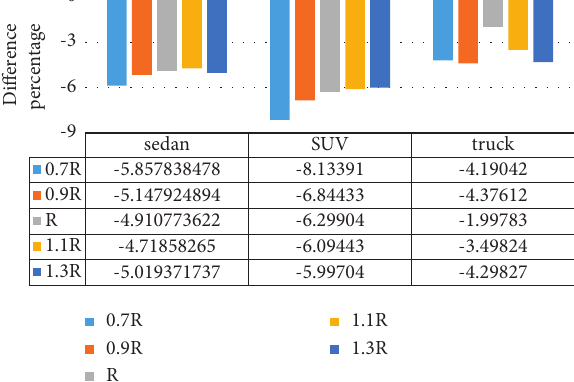
Figure 9: Difference percentage of the maximum lateral acceler- ations of simple and spiral curves with respect to the simple curve.